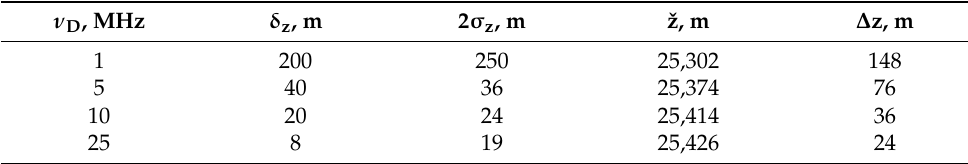
Figure 18. Gaussian approximation of z 1 obtained without interpolation for different ν D . Table 2. System parameters without interpolation.